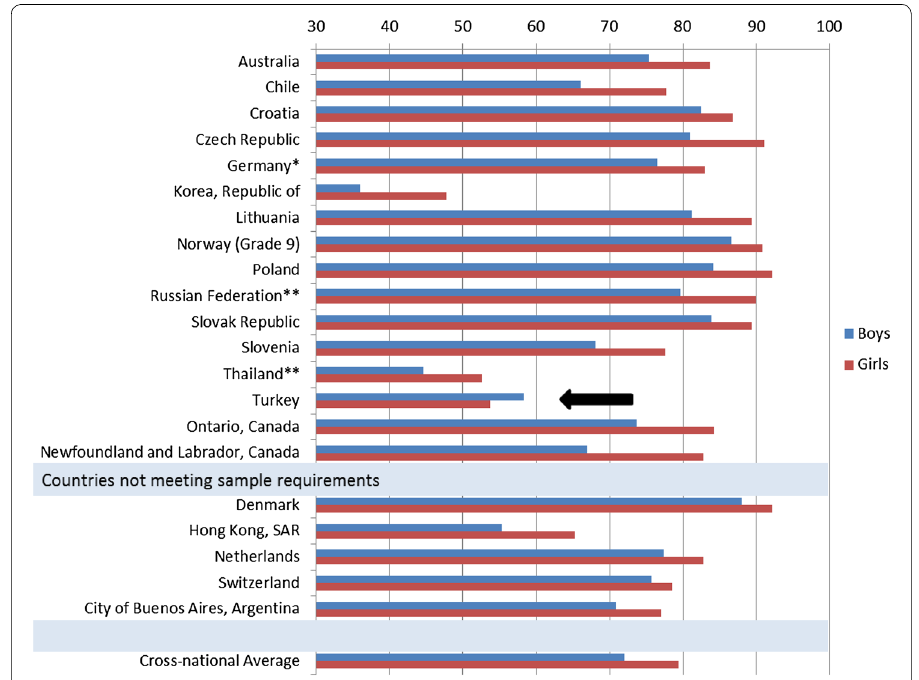
Fig. 7 Percentages of students using ICT for communicating at least once a week by